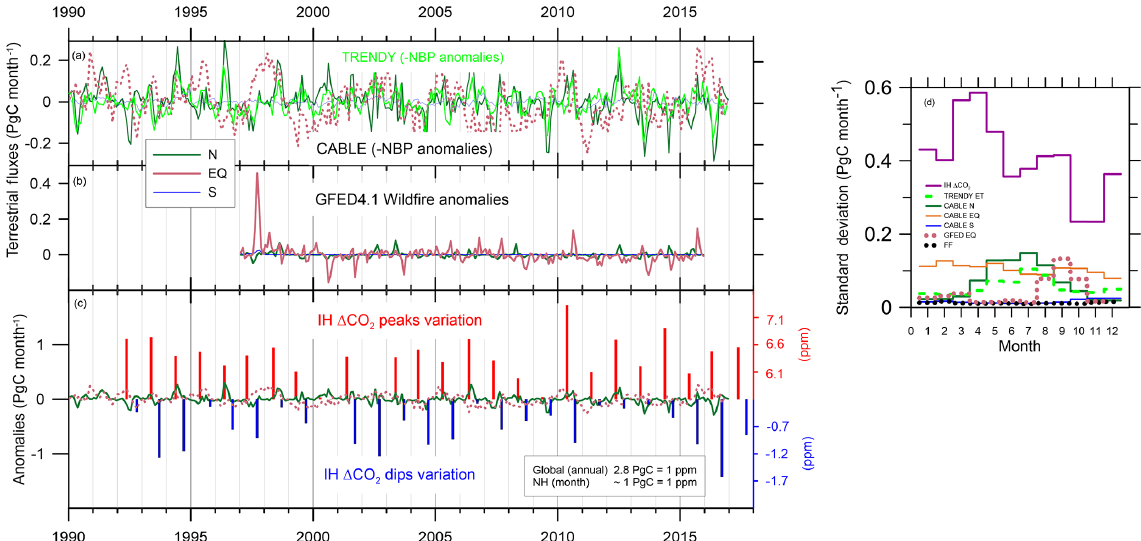
Figure 4. Comparison of the timing and amplitude of terrestrial emission anomalies (i.e. mean seasonality subtracted) with variations of the peaks and dips in Fig. 3. (a) shows seasonal anomalies in CABLE emissions (dark green) and in 16-DGVM TRENDY ET emissions (Bastos et al., 2018; light green) and (b) shows GFED4.1 wildfire seasonal anomalies, for NH (green), EQ (pink), and SH (blue, SH/EQ for GFED4.1). In (c) the largest anomalies (CABLE NH, CABLE EQ, and GFED4.1 EQ) on the left axis are compared to theppm variation in peaks (red) and dips (blue) on separate right axes. The axes scaling equates 1PgC with 1ppm (see text). To highlight seasonal differences, (d) shows the standard deviation in the seasonal anomalies for each month, including those in anthropogenic emissions (Oda et al.,